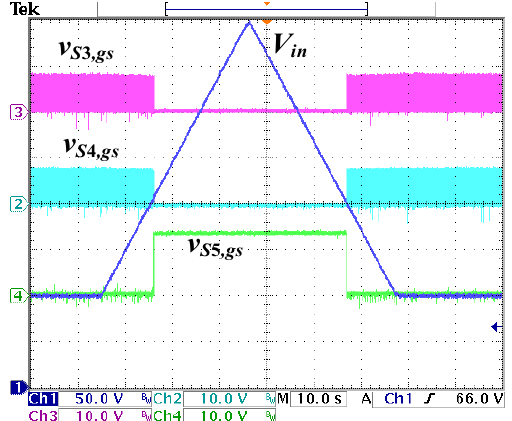
Figure 17. Measured waveforms of S 3 – S 5 and V in between V in = 100 and 400 V.